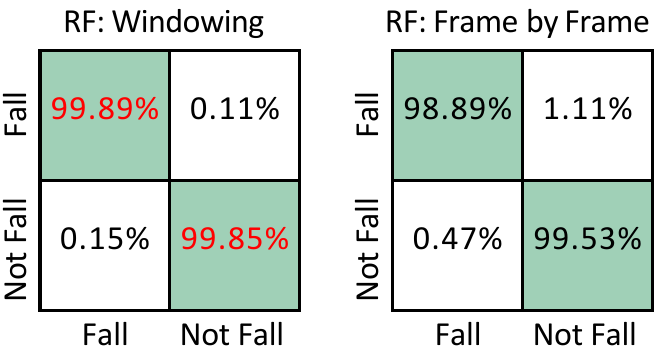
Figure 6. Comparison of confusion matrices for fall detection using UP-Fall: RF proposed method (left) vs. Frame by Frame+RF (right) [12]. Best results are shown in red.